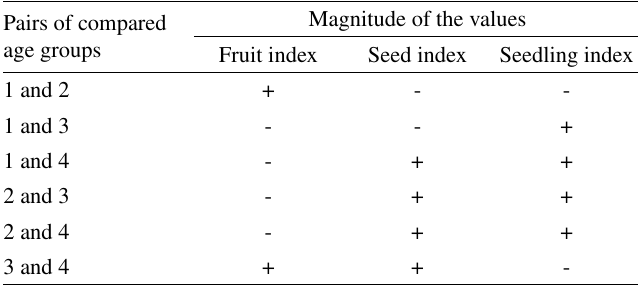
Table 6 - Direction of association of six discriminant function coeffi- cients involving the four age groups in mangosteen ( Garcinia mangostana